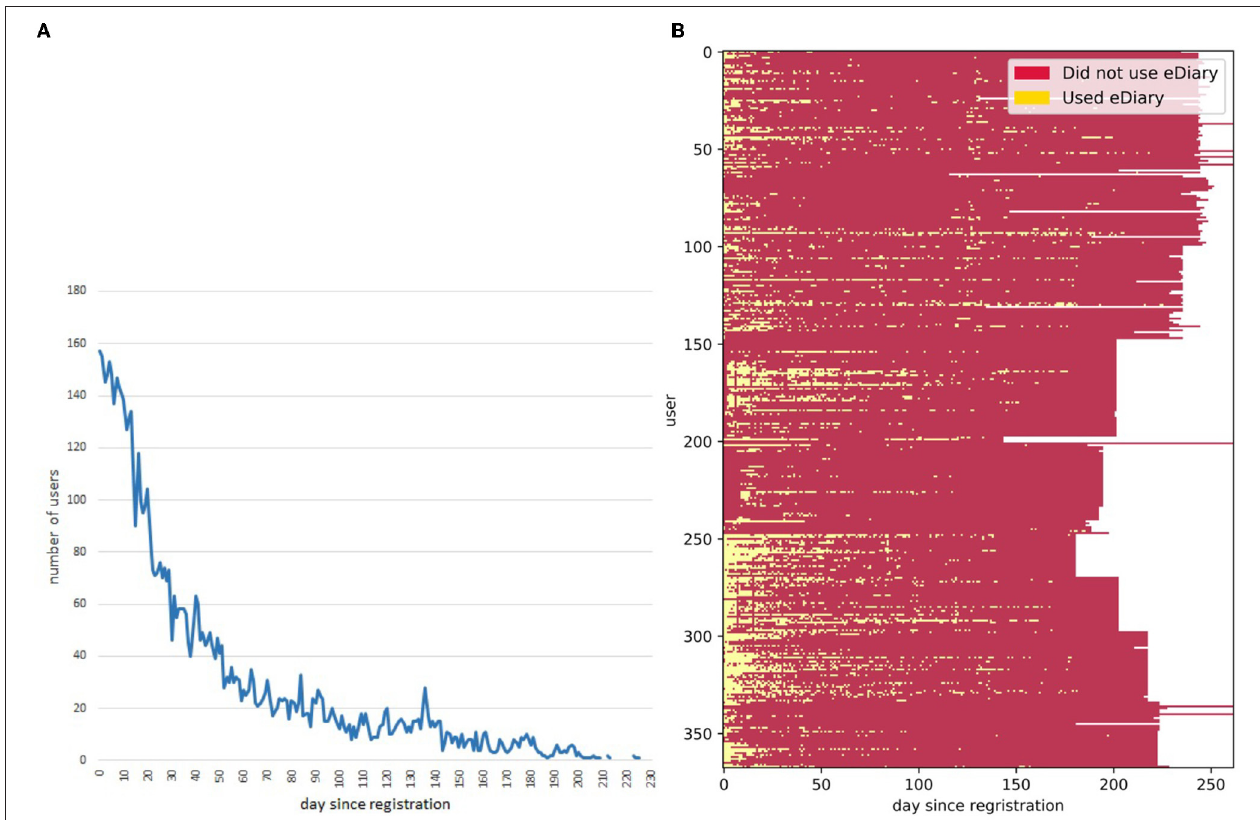
FIGURE 7 | Daily usage of the e-Diary mobile app over the intervention period. (A) Number of users since the first access to the system. The x-axis marking time in days of the graphs have been normalized such that day 1 corresponds to the first time the user accessed the system (i.e., at registration). (B) Usage matrix of the total number of active e-Diary users per day. A horizontal line in the matrix represents each user. Use of the e-Diary is marked in yellow (used) or red (did not use). Shorter usage lines are due to a shorter intervention period for a group of